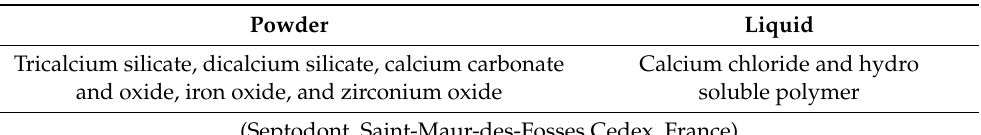
Table 1. Detail of the Biodentine ™ material. Powder Liquid Tricalcium silicate, dicalcium silicate, calcium carbonate Calcium chloride and hydro and oxide, iron oxide, and zirconium oxide soluble polymer (Septodont, Saint-Maur-des-Fosses Cedex,